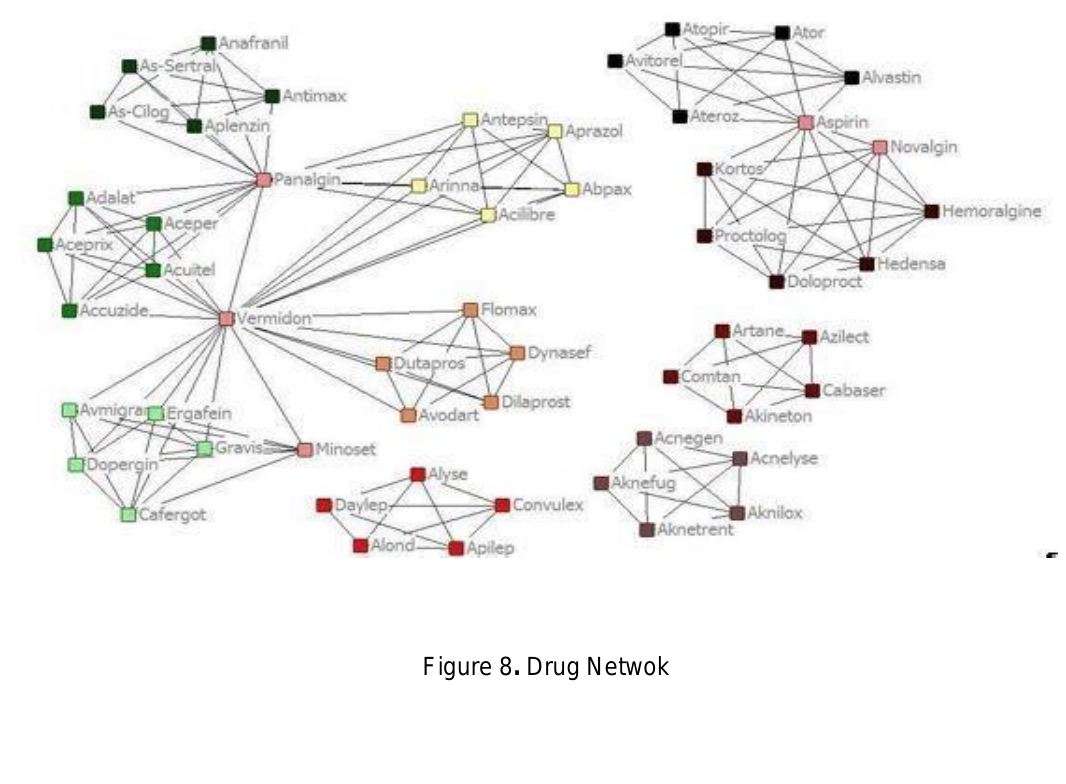
Figure 8 . Drug Netwok